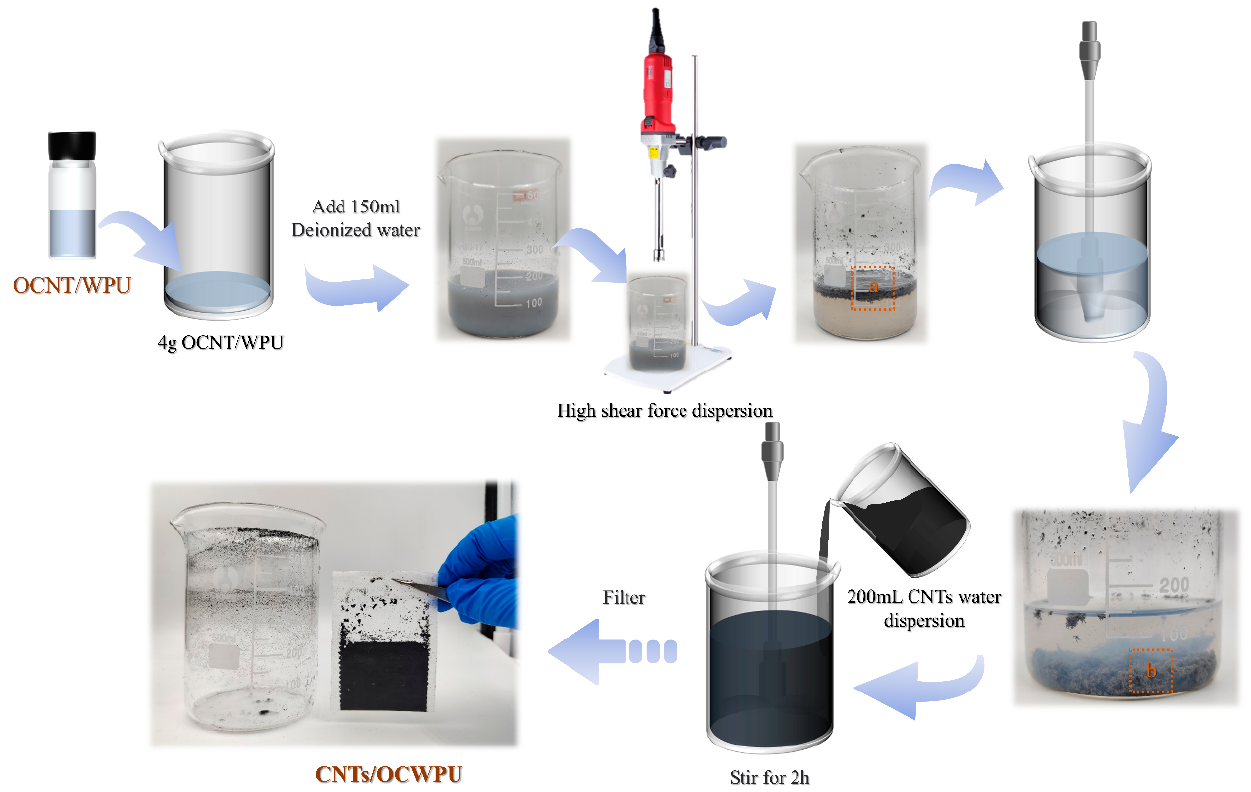
Figure 1. CNTs/OCWPU preparation process demonstration diagram. (a,b) as shown in Figure 2.